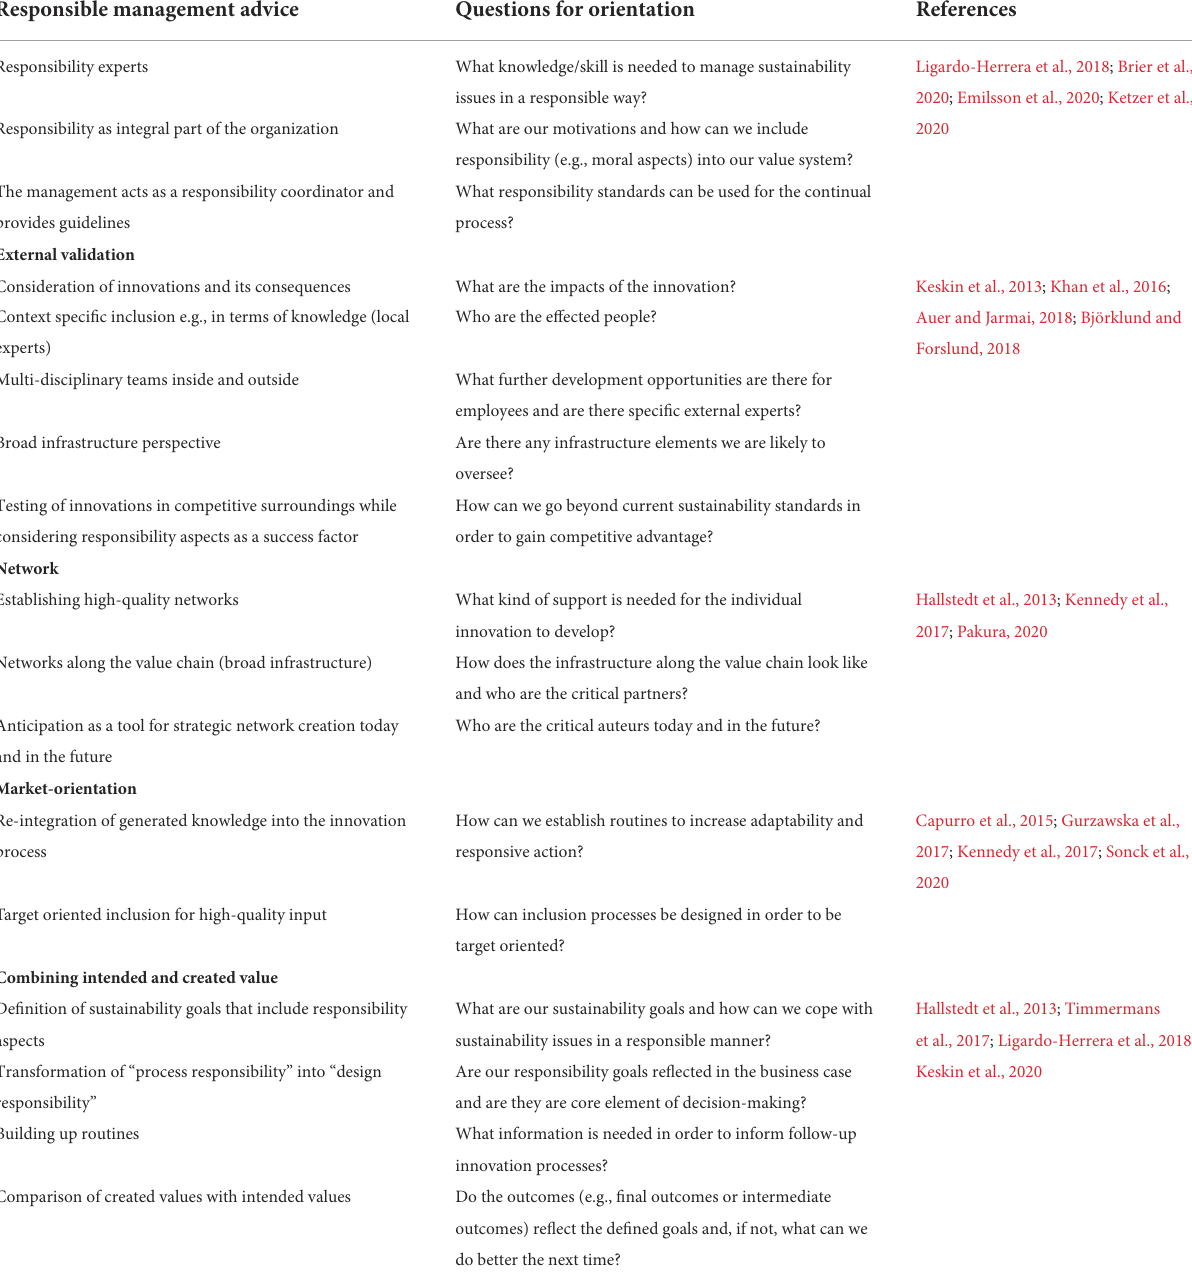
TABLE 6 Questionnaire for responsible management in innovation processes for